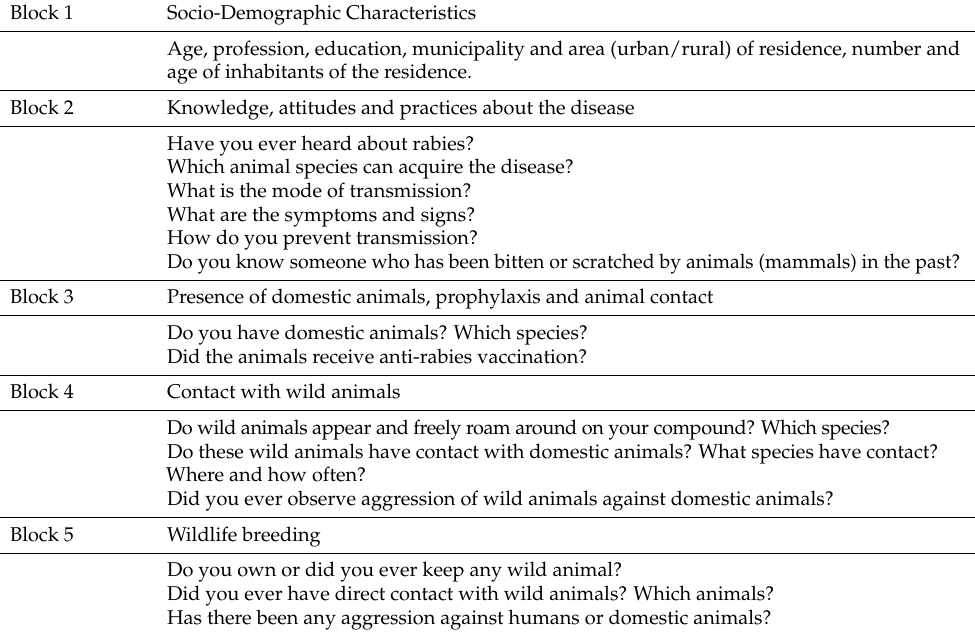
Table 1. Variables and questions on knowledge, attitudes and practices regarding rabies awareness and prevention, with focus on wildlife rabies, Cear á ,